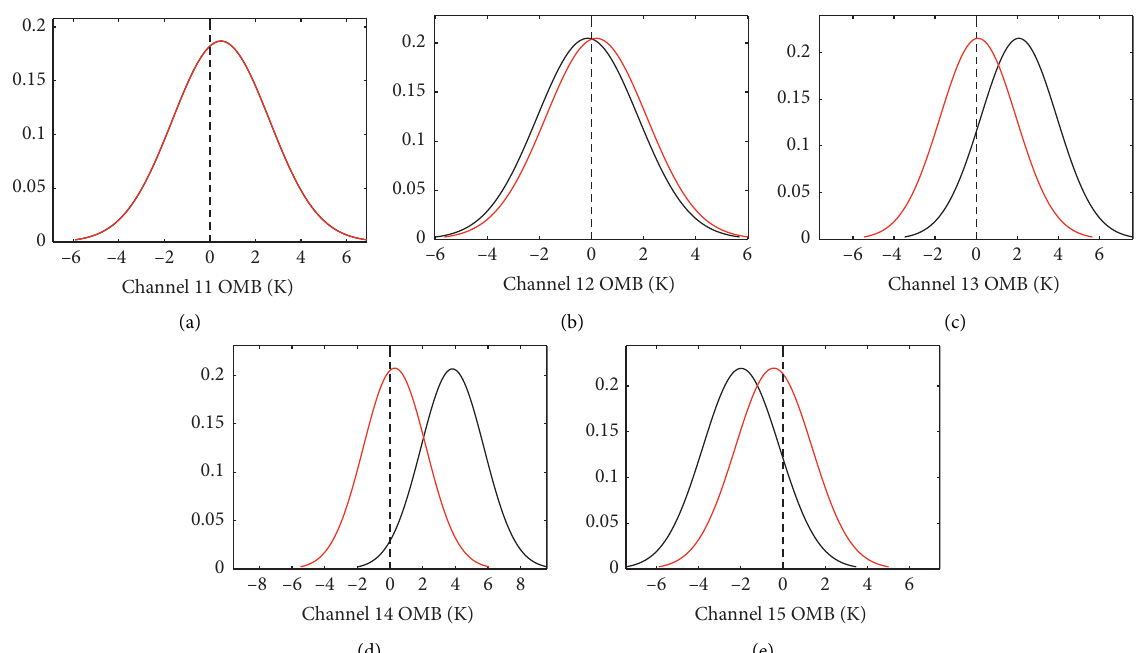
Figure 1: The PDF of the first-guess departures of the MWHS-2/FY-3C observations of channels 11–15 (a–e) at 0000 UTC 23 June 2016 before (black line) and after (red line)